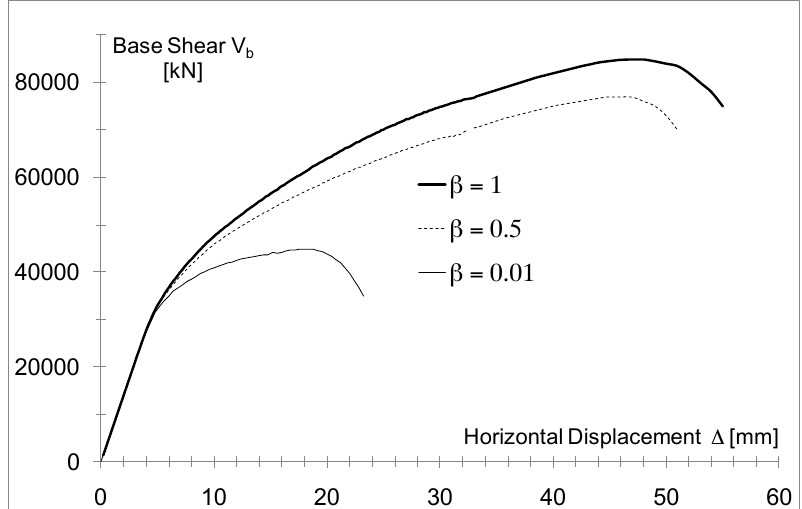
Figure 11. Capacity curves in direction +X for the three different values of β .